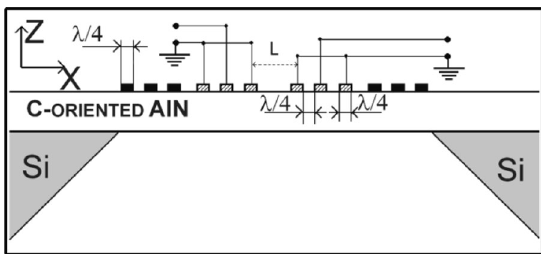
Fig. 6 Schematic of 2-port FPAR Lamb wave resonator resonator